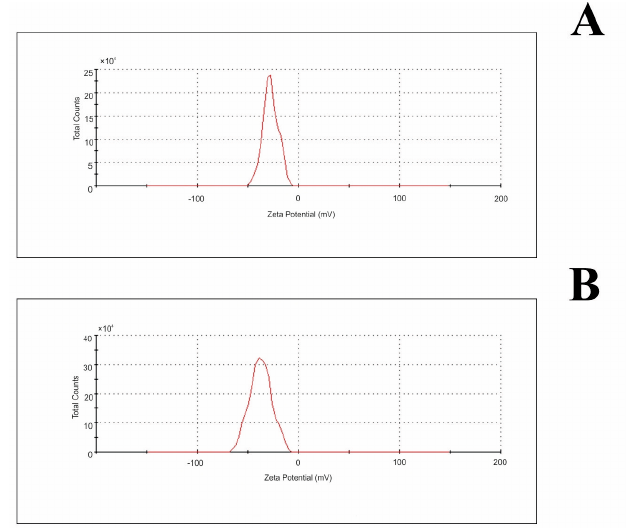
Figure 3. Zeta potential distribution of fullerenol NPs in water ( A ) and 0.02 M phosphate buffer pH 7.4 ( B ). pH 7.4 ( B